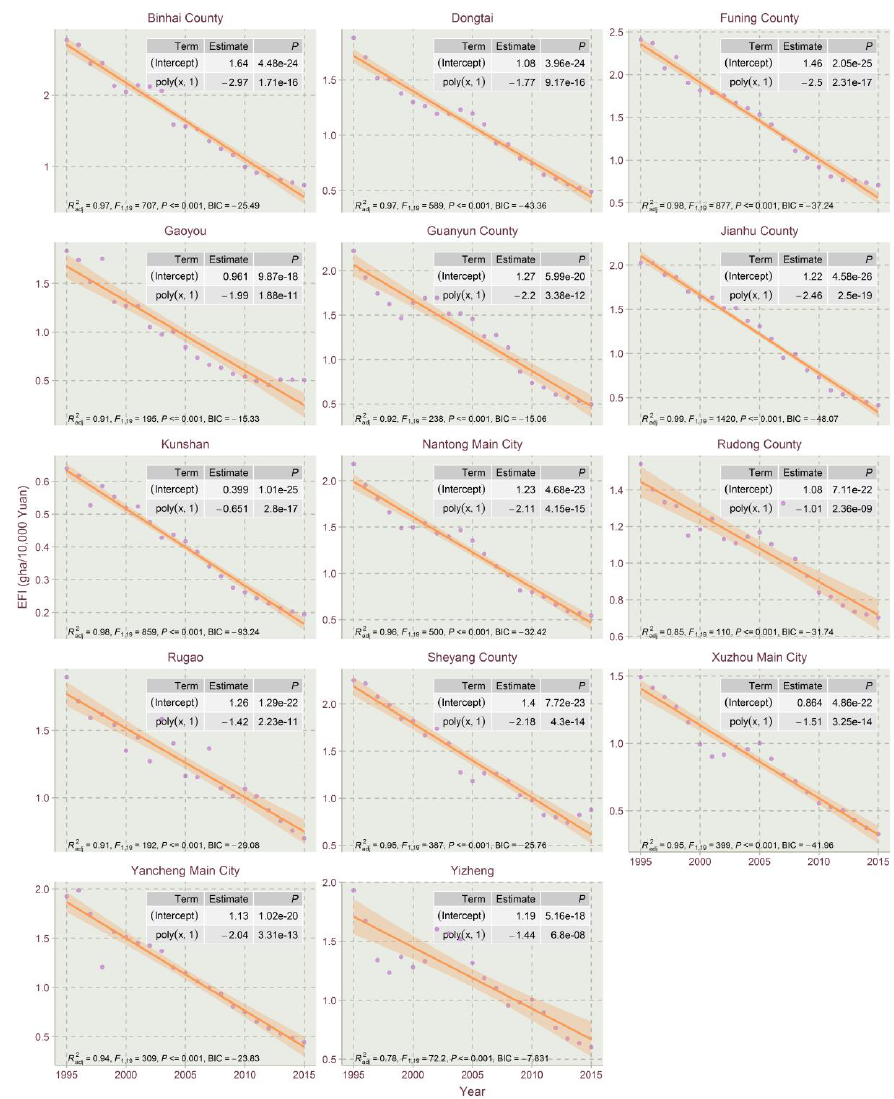
Figure 4. Linear orthogonal curve fitting of EFIs of Jiangsu Province for 1995 – 2015.